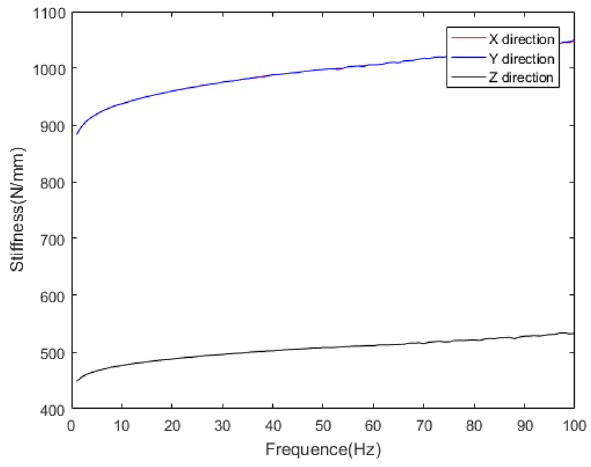
Figure 4. Relationship between translational stiffness in x/y/z direction and frequency.